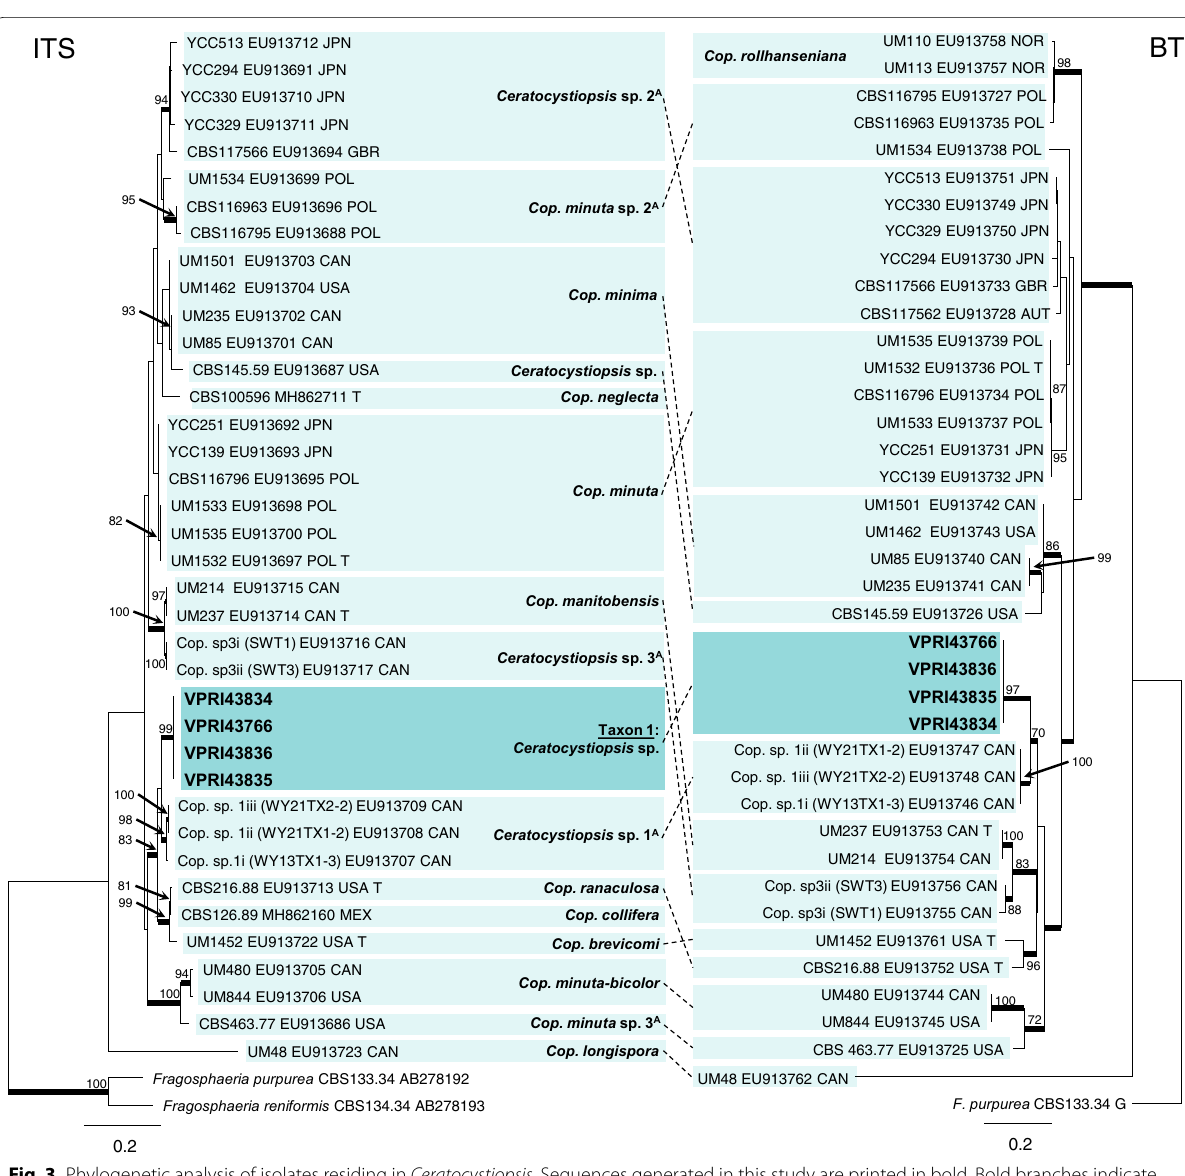
70% are recorded at nodes. T ex-type isolates, G sequence retrieved from ≥ = =